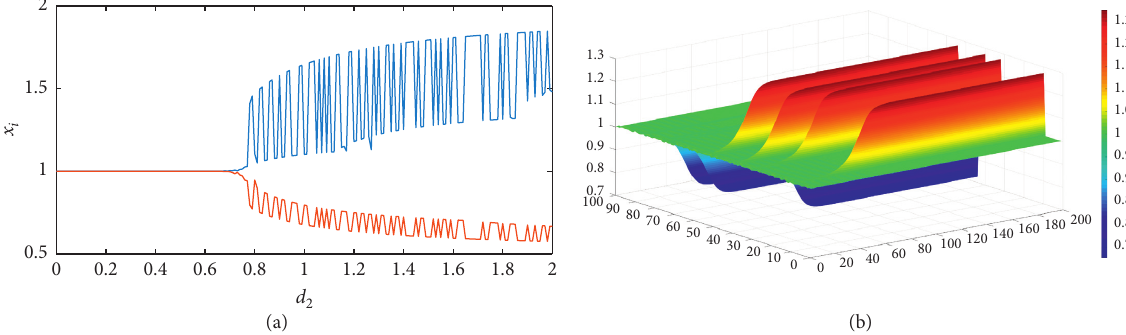
Figure 7: (a) The bifurcation diagram about d the system when p � 0 . 0005 and d